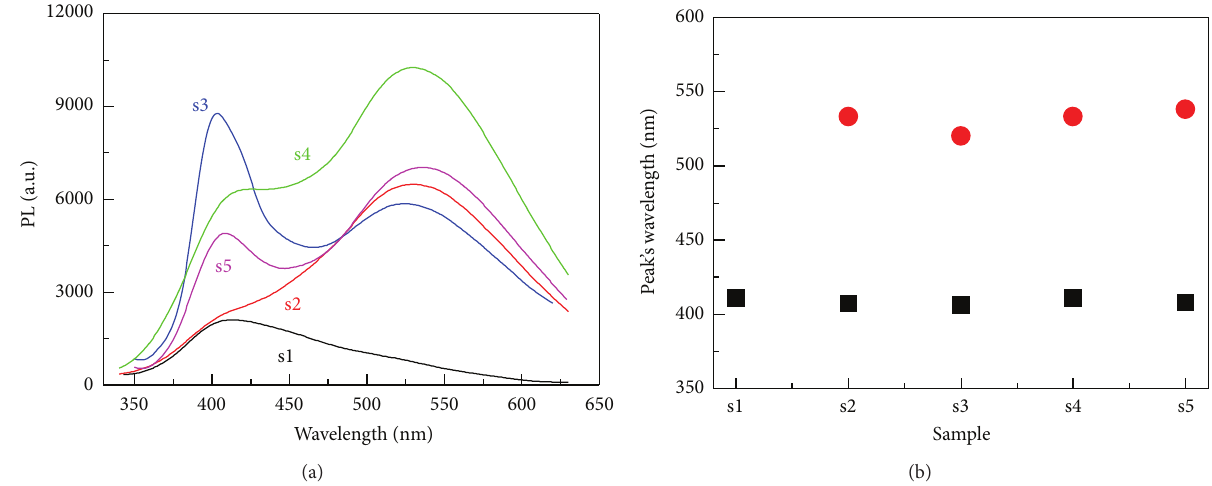
Figure 4: (a) Room-temperature photoluminescence spectra of the films measured at excitation wavelength of 325 nm and (b) wavelength position of PL peaks as a function of template